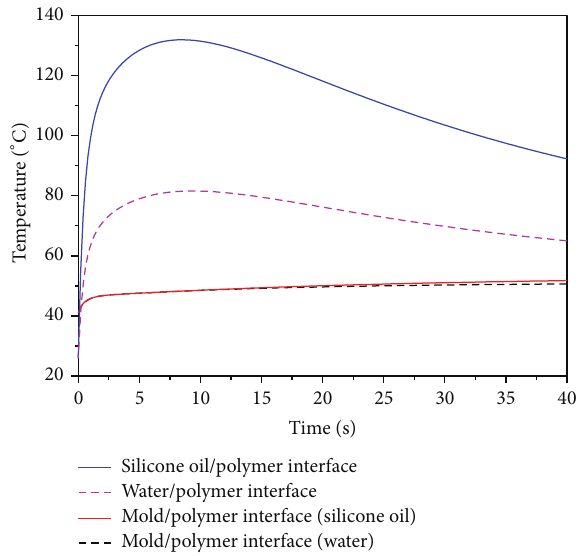
Figure 5: Result of heat transfer analysis for water and silicone oil.